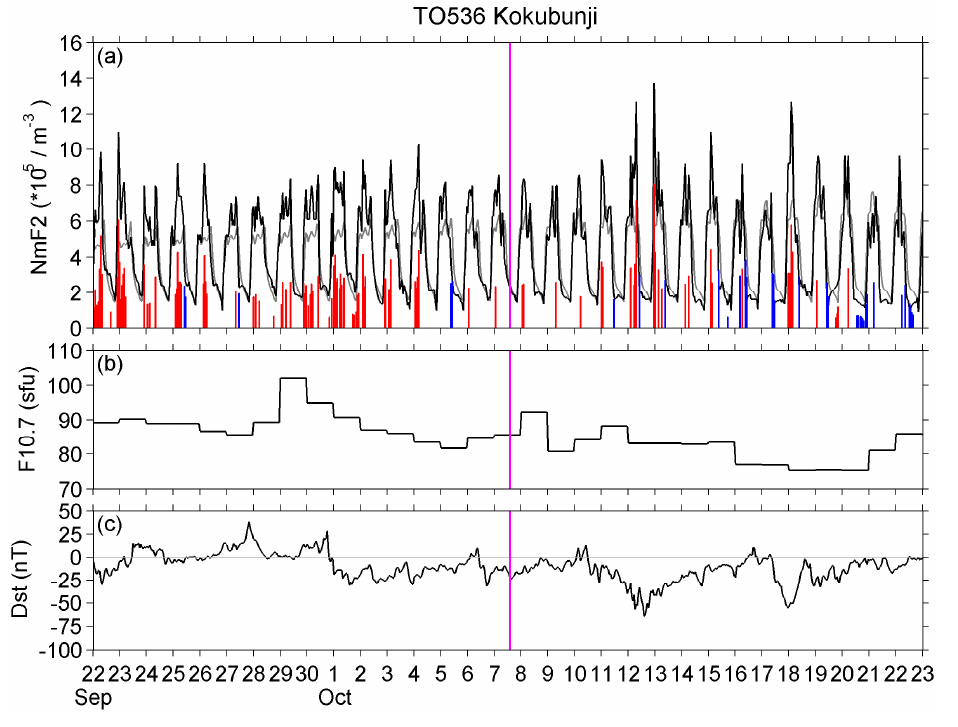
Figure 23. Same as in Figure 18, but panel ( a ) showing the NmF2 at Kokubunji. A vertical pink line indicates the EQ time. ( b ) Solar activity (F10.7) and ( c ) geomagnetic activity Dst index.